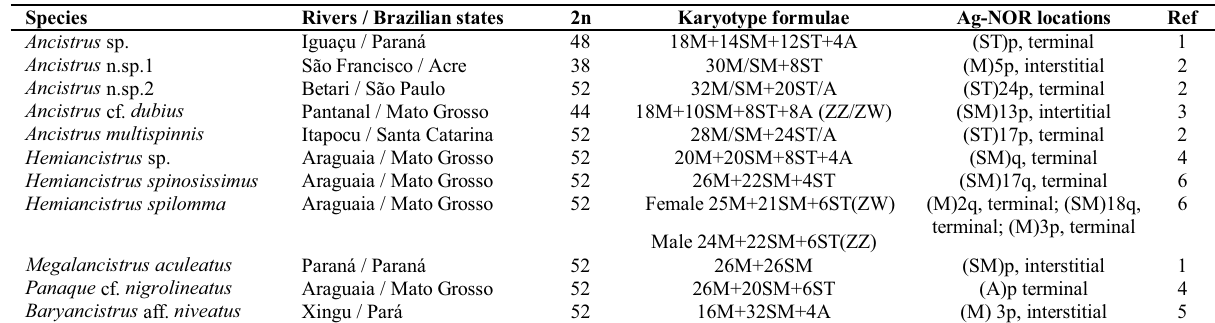
Table 1. Cytogenetic data from the species of Ancistrini. References: 1. Lara (1998), 2. Alves et al. (2003), 3. Mariotto et al . (2004), 4. Artoni & Bertollo (2001), 5. Souza et al . 2004, 6. present study. Species Rivers / Brazilian states